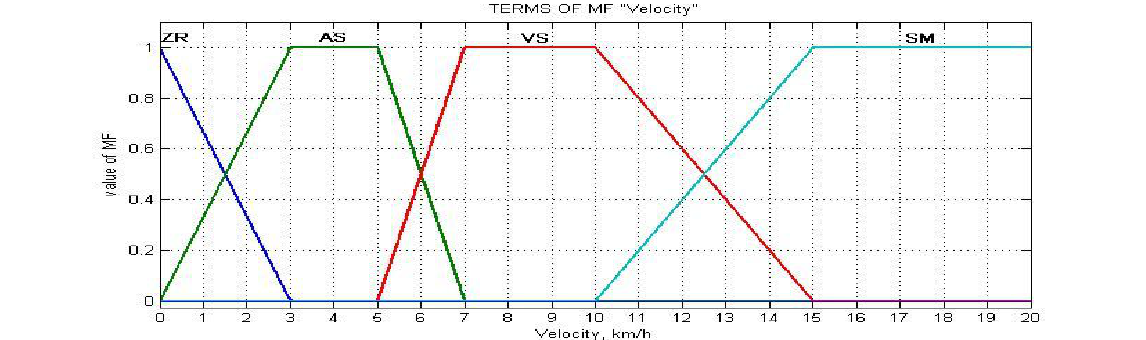
Fig. 6. Term-sets ZR, AS, VS, SM of linguistic variable “Velocity”